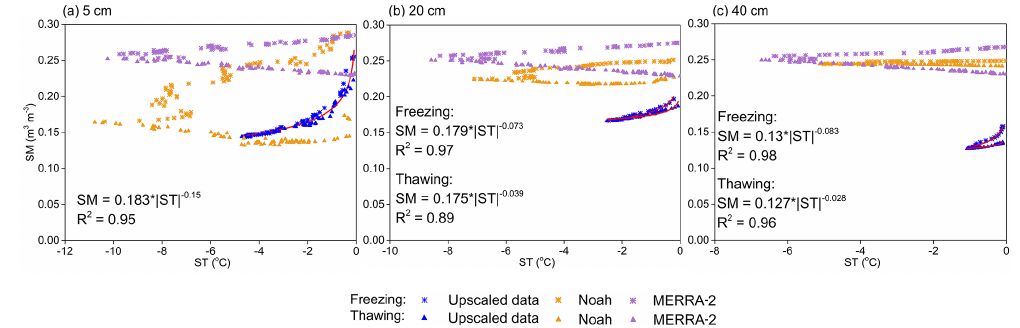
Figure 7. Soil freezing characteristics for depths of (a) 5, (b) 20, and (c) 40cm, as determined from the measured and simulated unfrozen SM and subzero ST obtained from the upscaled dataset, GLDAS Noah, and MERRA-2 products, for the Maqu